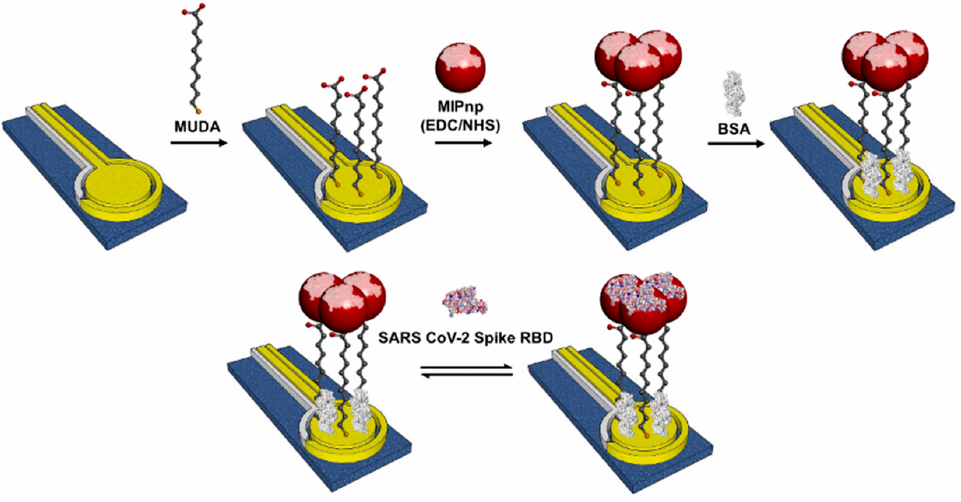
Figure 1. Surface modification protocol of the Au ‐ SPE with MUDA, NanoMIP (crosslinked atop MUDA through EDC/NHS chemistry), and BSA. The rebinding of SARS ‐ CoV ‐ 2 spike glycoprotein is therein indicated through reversible arrows, within the imprinted cavities towards the RBD of the SARS ‐ CoV ‐ 2 spike glycoprotein.